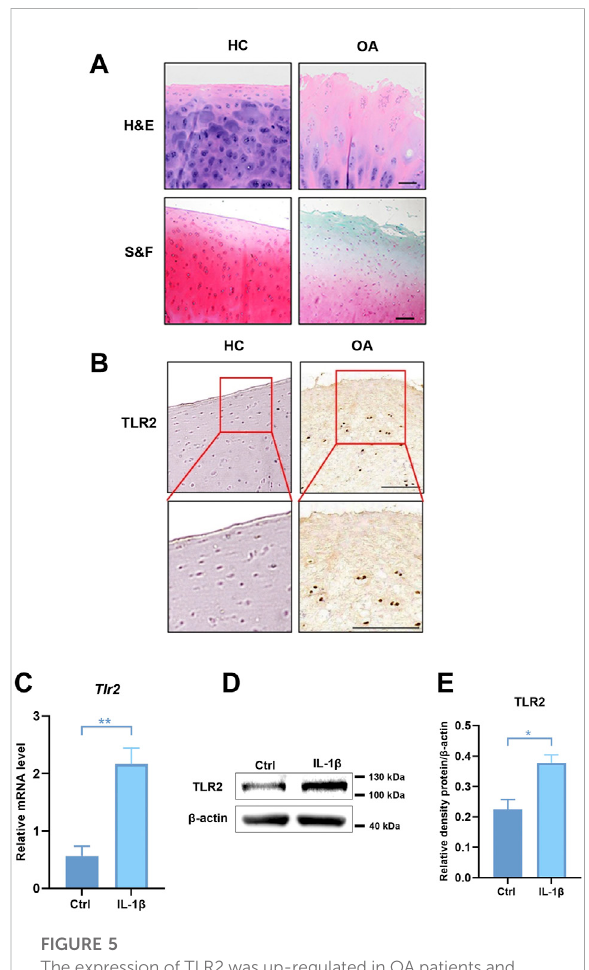
FIGURE 5 The expression of TLR2 was up-regulated in OA patients and in human chondrocytes treated with IL-1 β . (A) H&E and S&F staining ofhealthycontrol and OA patients (scale bar:200 μ m). (B) Immunohistochemical staining for TLR2 in healthy control and human OA samples. (C) The mRNA levels of TLR2 in hCHs treated with or without IL-1 β (10 ng/ml) were assayed by real-time PCR. (D) Representative Western blot results for TLR2 in hCHs treated with or without IL-1 β (10 ng/ml). (E) Quanti fi cation of Western blot data from (D) . All data represent mean ± S.E.M.* p < 0.05, ** p < 0.01. All experiments were repeated 3